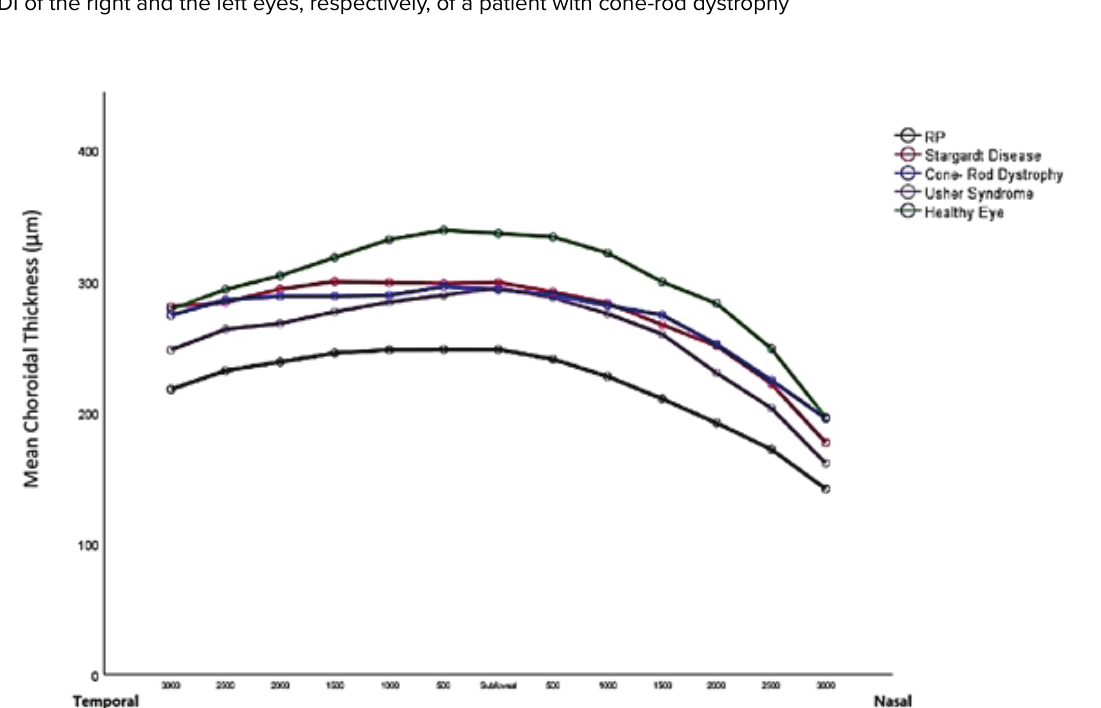
Figure 2. Mean choroidal thickness in the subfoveal area and at six different spots along the nasal and the temporal directions in different types of inherited retinal